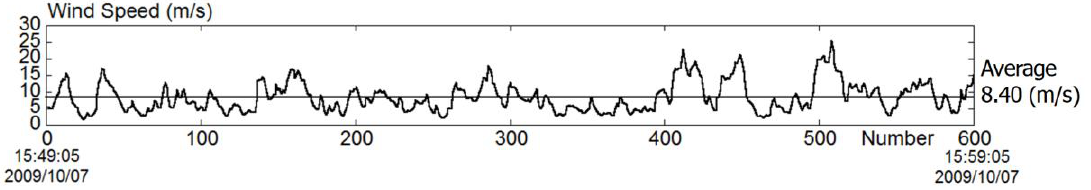
Figure 7. Tine series of 1 s average wind-speed data from the hub height (50.0 m) of Wind Turbine No.